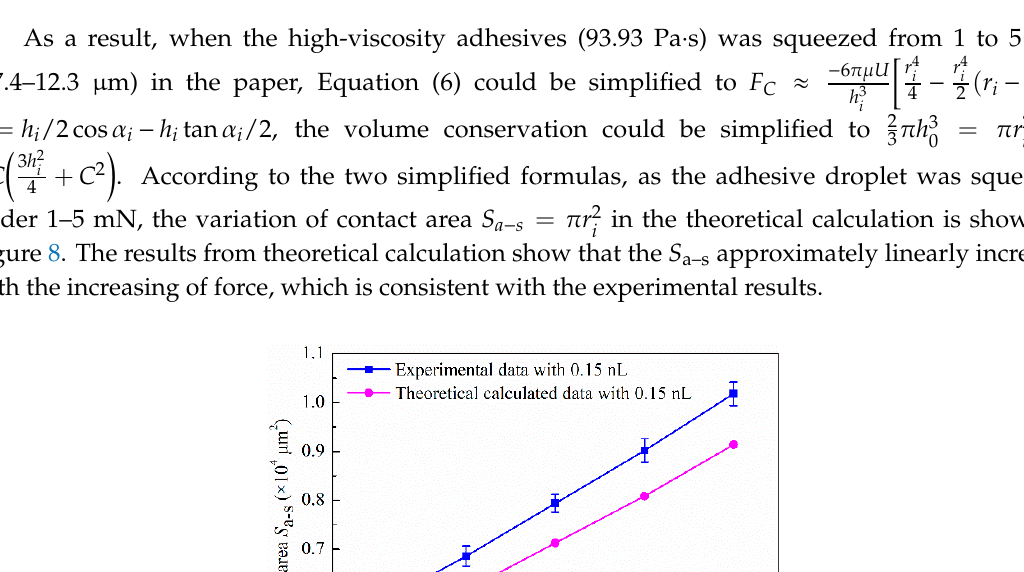
Figure 7. Variation of surface tension force ( F s ) and viscous force ( F v ) with the decrease of slit pitch at ( A ) initial squeezing, ( B ) 1 mN, and ( C ) 5 mN.